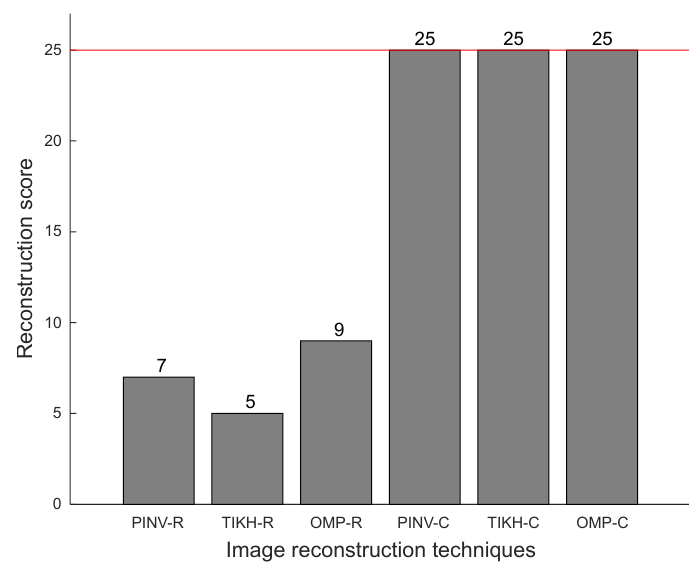
Figure 13. Reconstruction scores with a single obstacle in the environment.